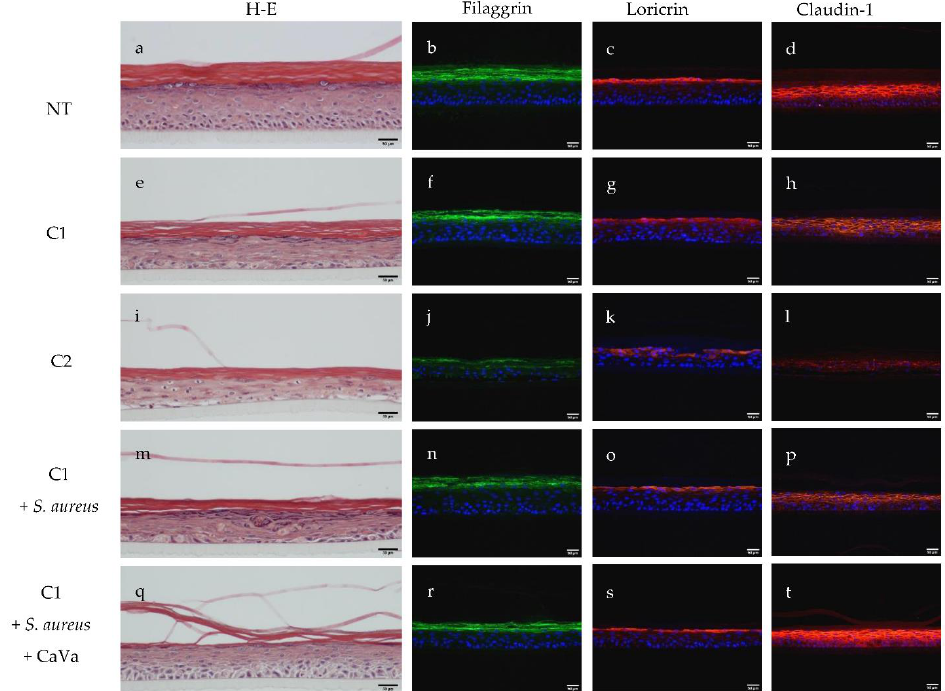
Figure 1. Effect of treatments of reconstructed human epidermis (RHE) with either a cocktail of inflammatory cytokines alone, both the cocktail and S. aureus or the cocktail with S. aureus and an extract of Castanea sativa leaves. RHEs were untreated (NT; ( a – d )) or treated with TNF α and a cocktail of Th2-related cytokines (IL-4, IL-13 and Il-31) at 5 ng/mL (C1) or 20 ng/mL (C2) (( e – h ) and ( i – l ), respectively). In some cases, S. aureus was topically applied on the RHEs treated with the lowest concentration of cytokines ( m – t ), without ( m – p ) or with ( q – t ) additional treatments with an extract of Castanea sativa leaves. Sections of RHEs were stained with hematoxylin – eosin (H-E; ( a , e , i , m , q )) and immunodetected with antibodies directed to filaggrin (( b , f , j , n , r ); green), loricrin (( c , g , k , o , s ); red) and claudin-1 (( d , h , l , p , t ); red). Nuclei were stained with 4 ′ ,6-diamidino-2-phenylindole (blue). Representative epifluorescence images are shown; scale bars = 20 µm.